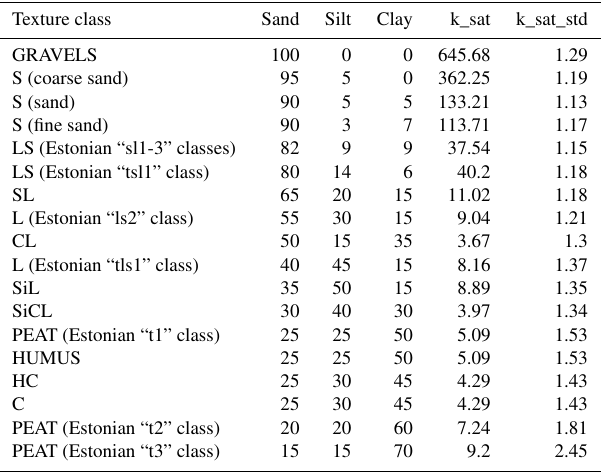
Table 5. Predicted K sat values in mm/h and reported standard de- viation from